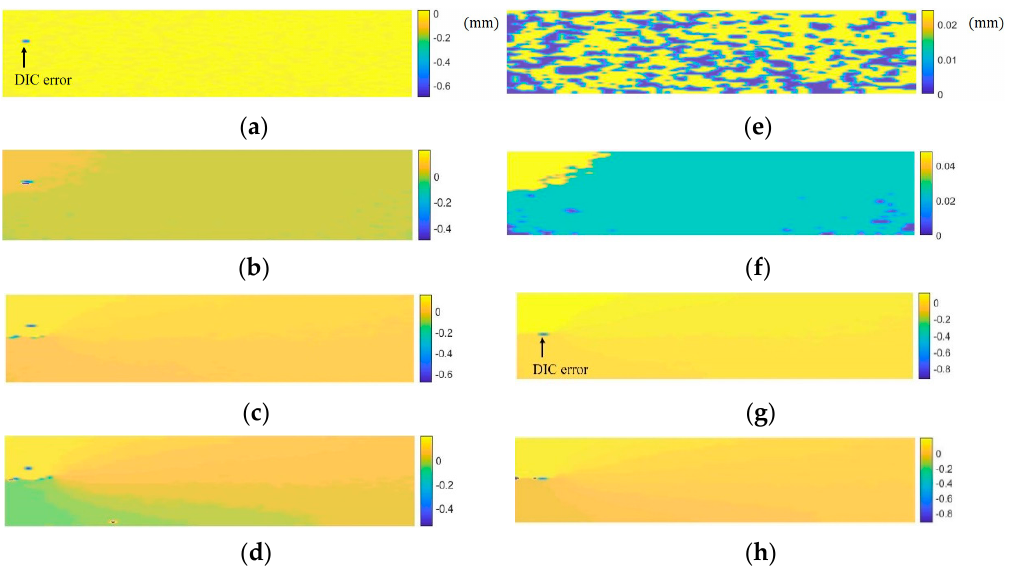
Figure 12. Determination of subset sizes using SSSIG at the randomly selected two different seed points: ( a ) seed point 1 and ( b ) seed point 2.